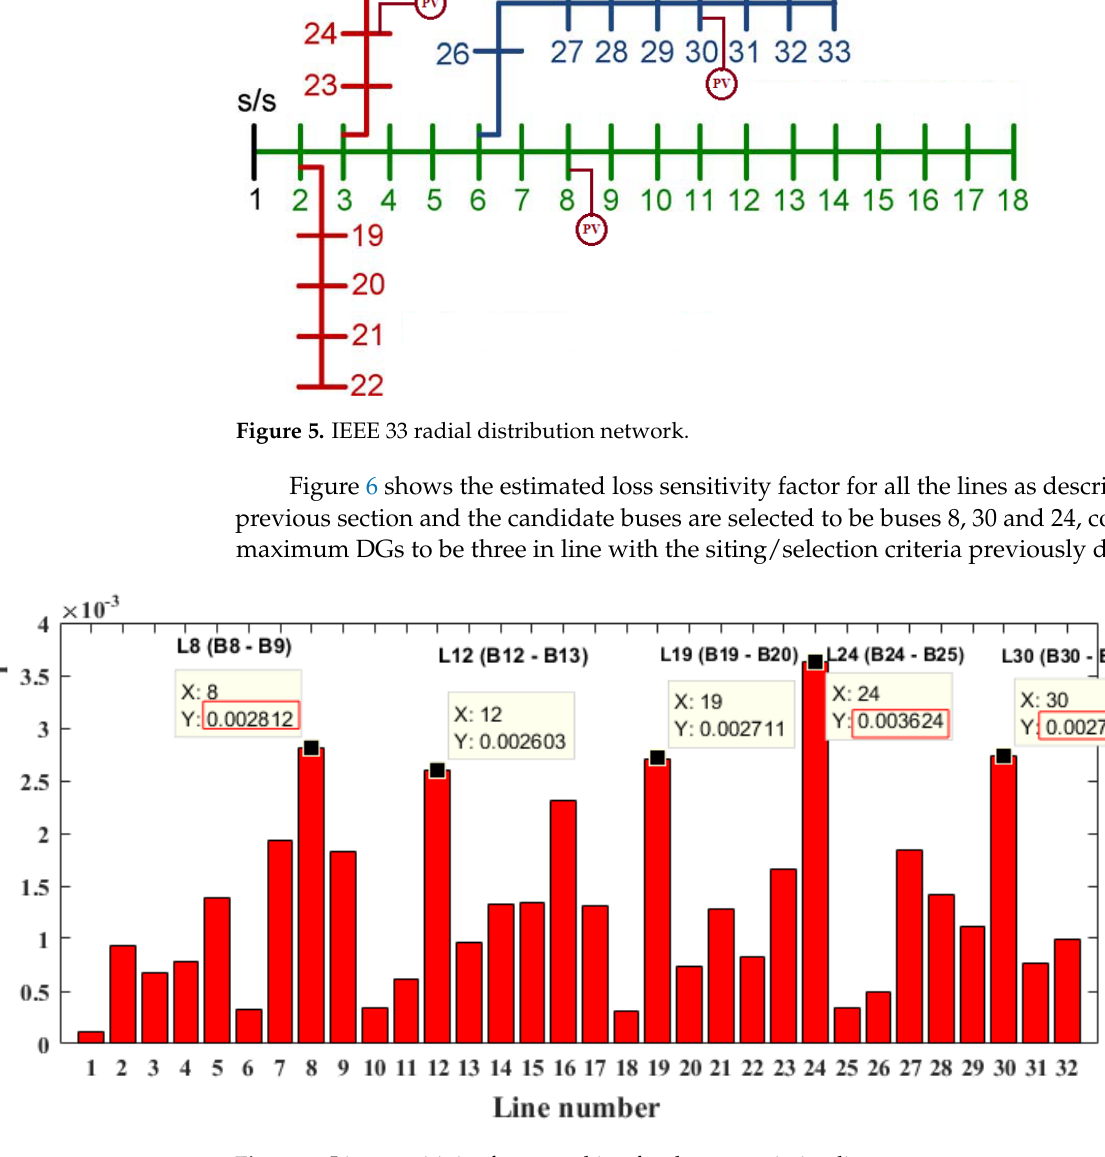
Figure 6. Line sensitivity factor ranking for the transmission